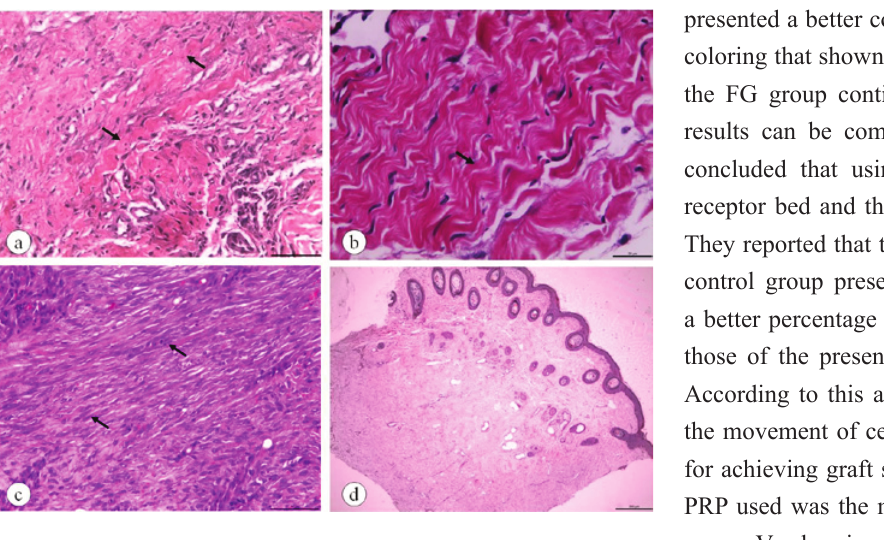
FIGURE 2 - A/B. Collagen fibers in a marked degree in the group CF treated, but without statistically significant differences. C. Fibroblasts in a marked degree in the group treated PRP. D. Panoramic image of the graft group CF